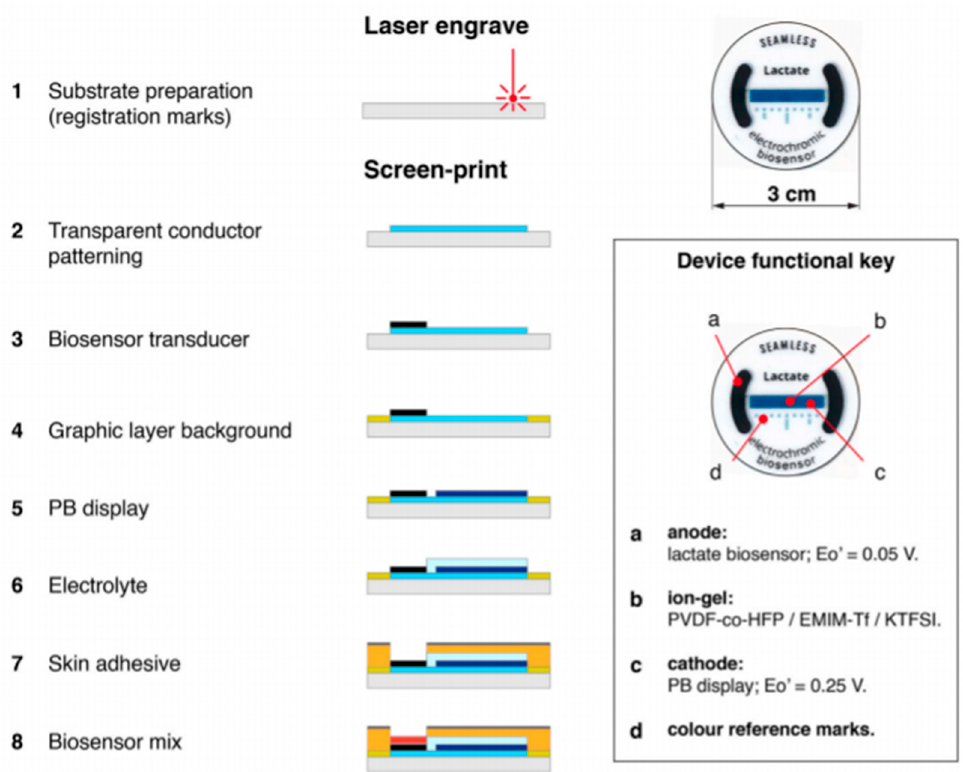
Figure 21. Diagrammatic representation of the fabrication process and photographs from two different prototype versions. The inset highlights the function of the device various components. Reprinted with permission from [210].